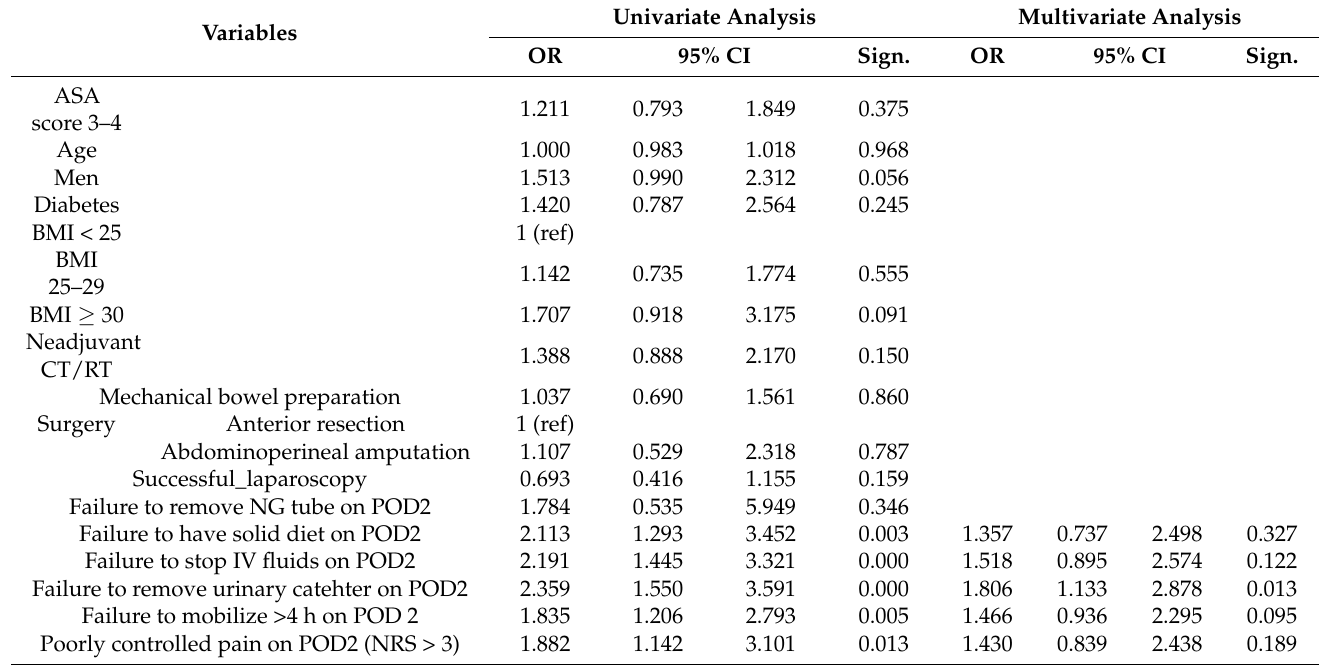
Table 5. Variables associated with any complication.